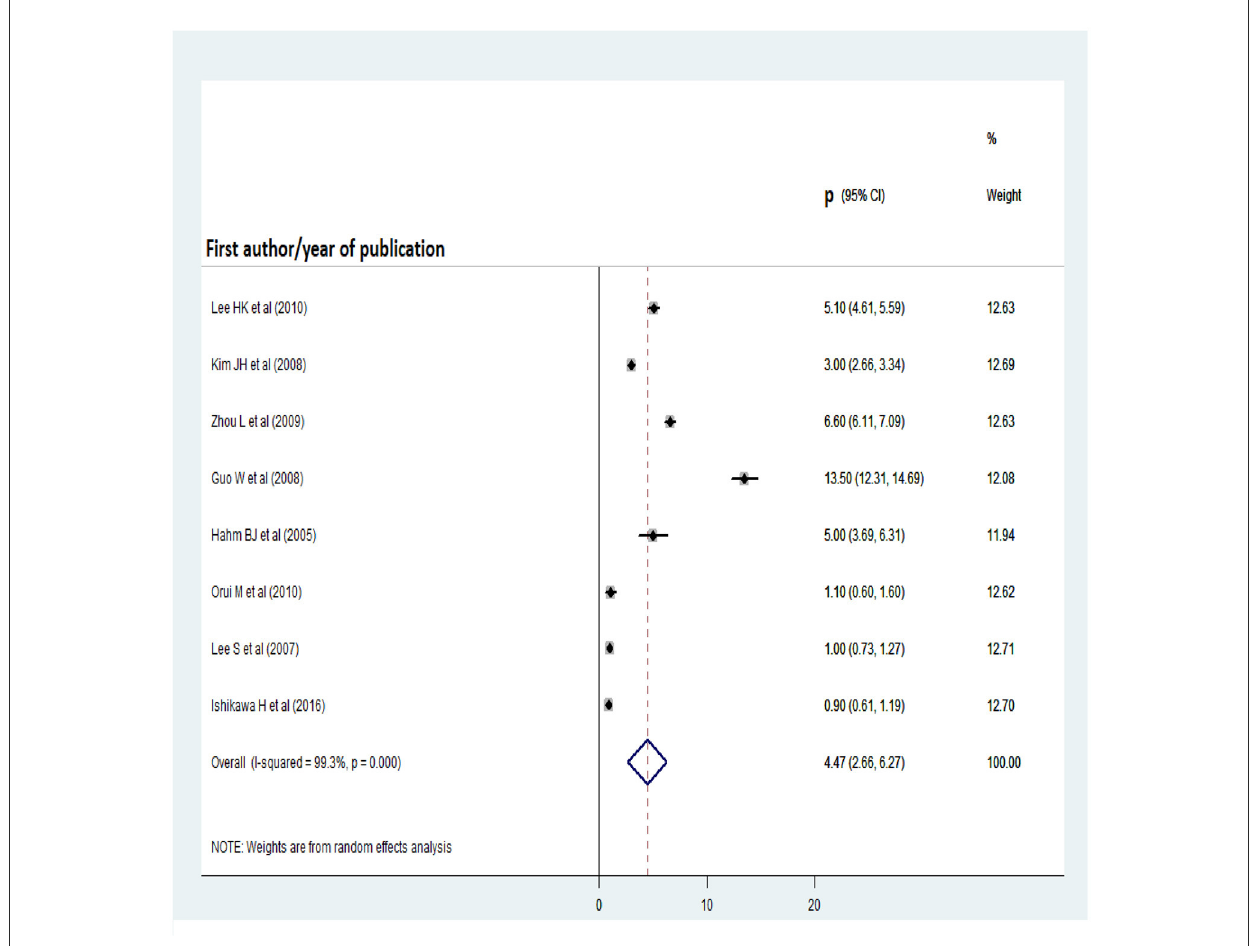
FIGURE7 Forest plot for pooled prevalence of alcohol